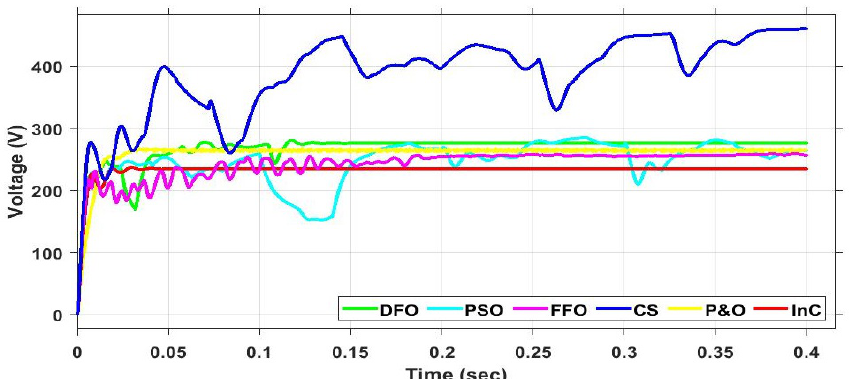
Figure 27. PS1 voltage comparison between all algorithms for MLPE Distributed PV system.